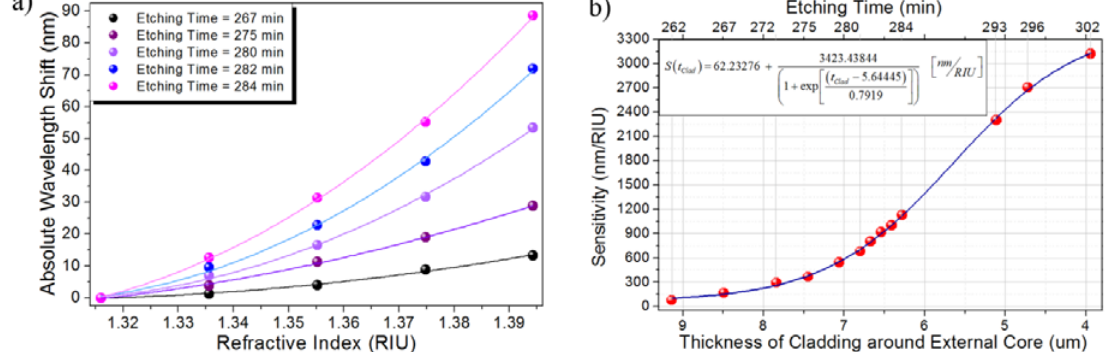
Figure 7. ( a ) Absolute wavelength shift of the sensor response for external media ranging from water to ethylene glycol; ( b ) Sensitivity of the RI sensor as a function of the thickness of the cladding around the off-axis